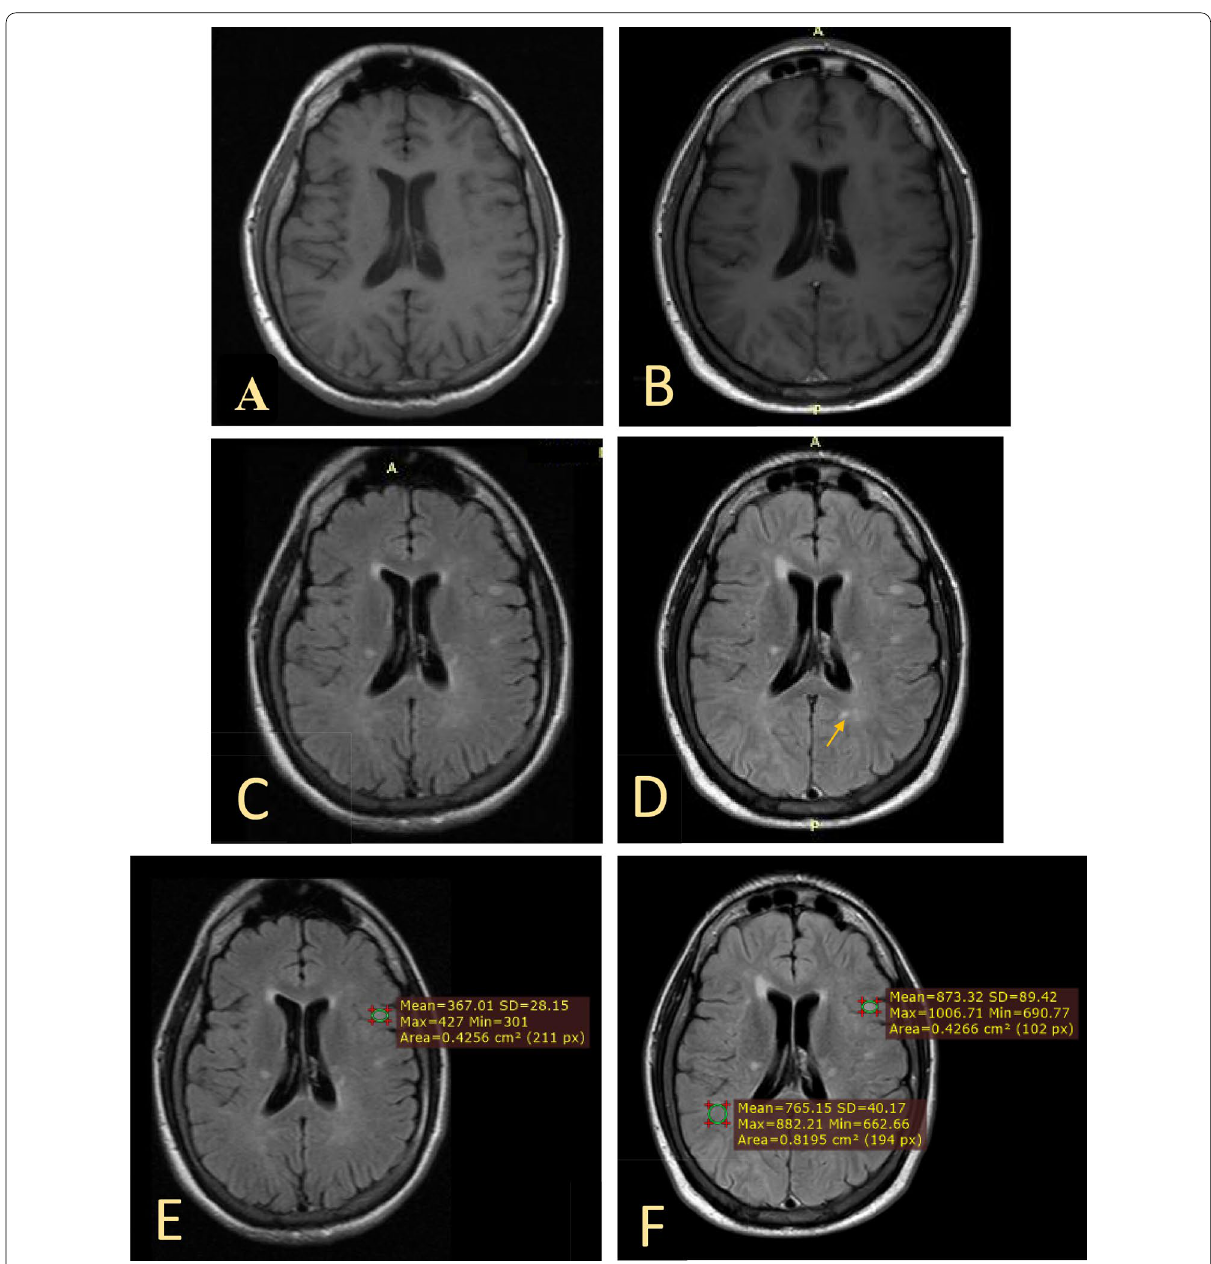
Fig. 4 Male patient aged 27 years old, known case of MS on follow‑up presented by clinical signs of activity. A , B Axial pre and post contrast T1WI: show multiple hypointense lesions in the periventricular white matter with no definite enhancing lesions on post contrast study. C Axial pre‑contrast FLAIR shows multiple foci of high signal intensity at periventricular white matter. D Axial CE‑FLAIR: shows nodular enhancement of MS plaques (arrows) which were not detected in pre contrast FLAIR (denoting more number of enhancing lesions shown in CE‑FLAIR sequence without corresponding enhancement in post contrast T1W image. E , F Axial pre and post contrast FLAIR at same level: measurements of the SI, denoting the difference between pre and post contrast and confirms the presence of enhancement (CEI Final Diagnosis: A case of MS with signs of